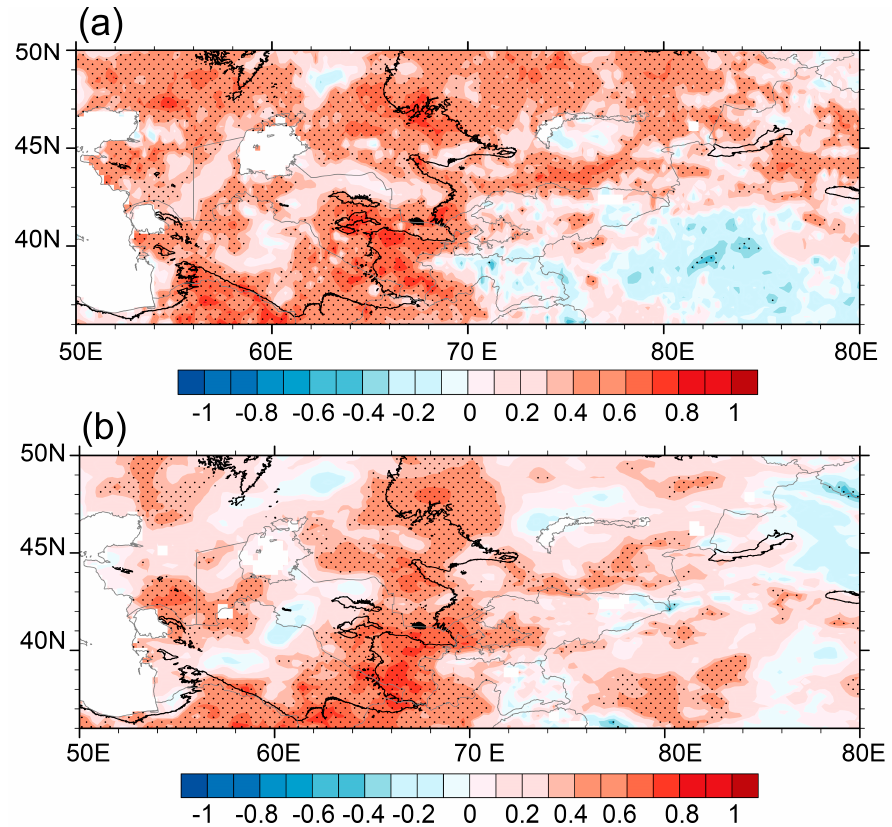
Figure 6. ( a ): The lagged response of NDVI to precipitation. Distribution of correlation coefficients between winter precipitation (here referring to the pre-growing precipitation) and growing season NDVI; ( b ): distribution of correlation coefficients between winter precipitation and growing season soil water.